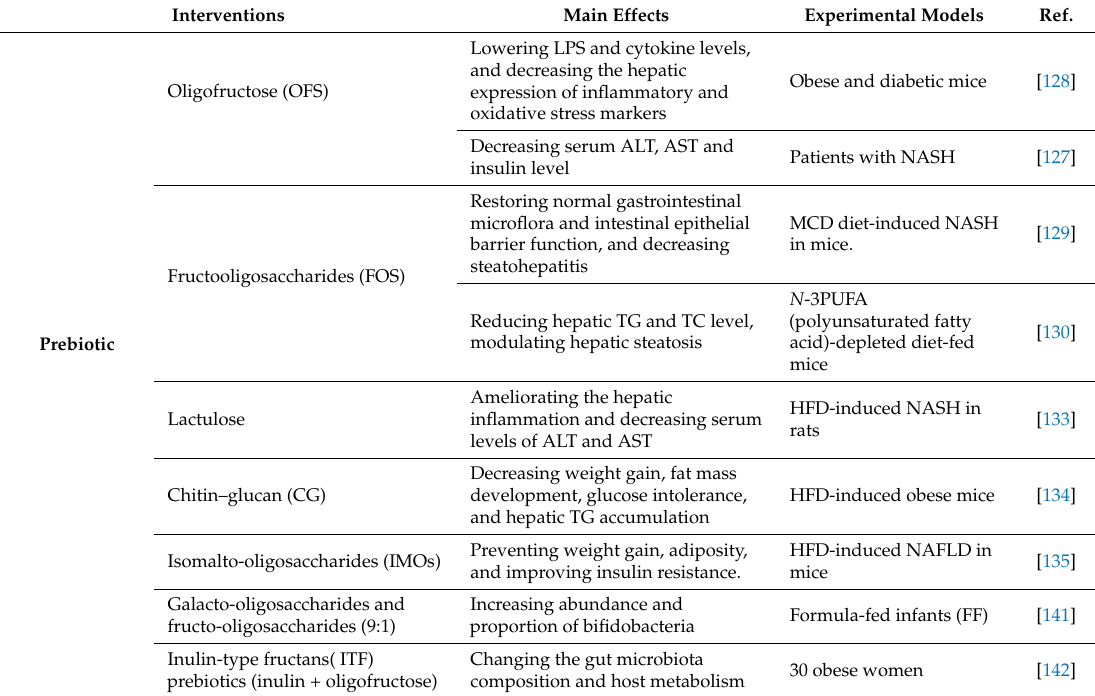
Table 2. Gut microbiota-targeted therapies of NAFLD with prebiotics. Interventions Main Effects Experimental